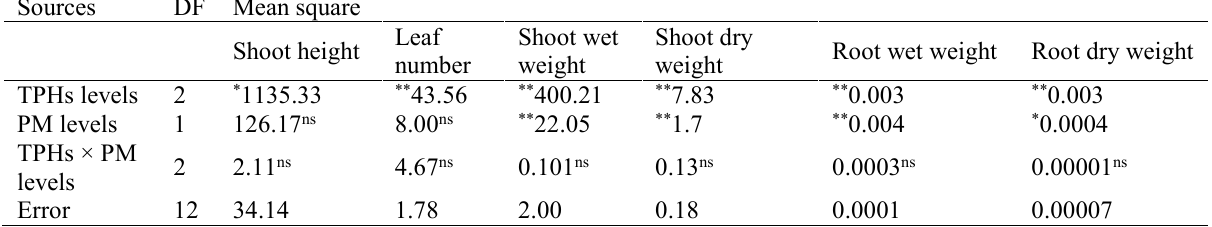
Table 3. Results of analysis of variance regarding physiological parameters of oat plants at TPH and PM levels